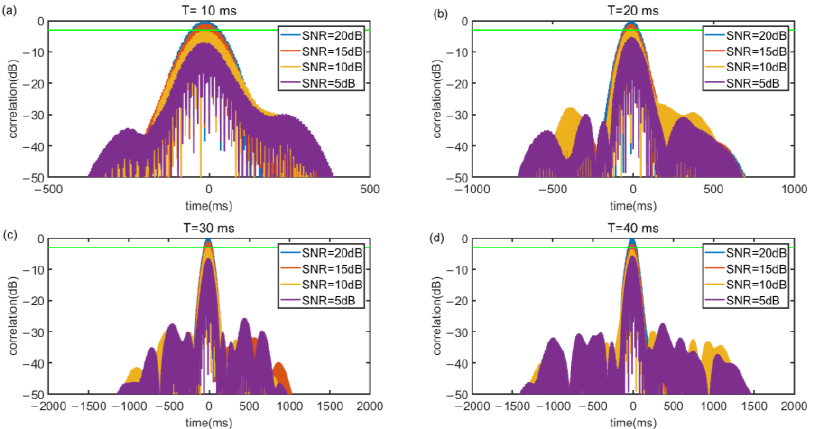
Figure 8. Autocorrelation power spectrograms of different T in the case of Gaussian noise with a bandwidth of 1 kHz. ( a ) T = 10 ms, IRW = 2.8 ms ( b ) T = 20 ms, IRW = 2.3 ms ( c ) T = 30 ms, IRW = 1.4 ms ( d ) T = 40 ms, IRW = 1.1 ms.